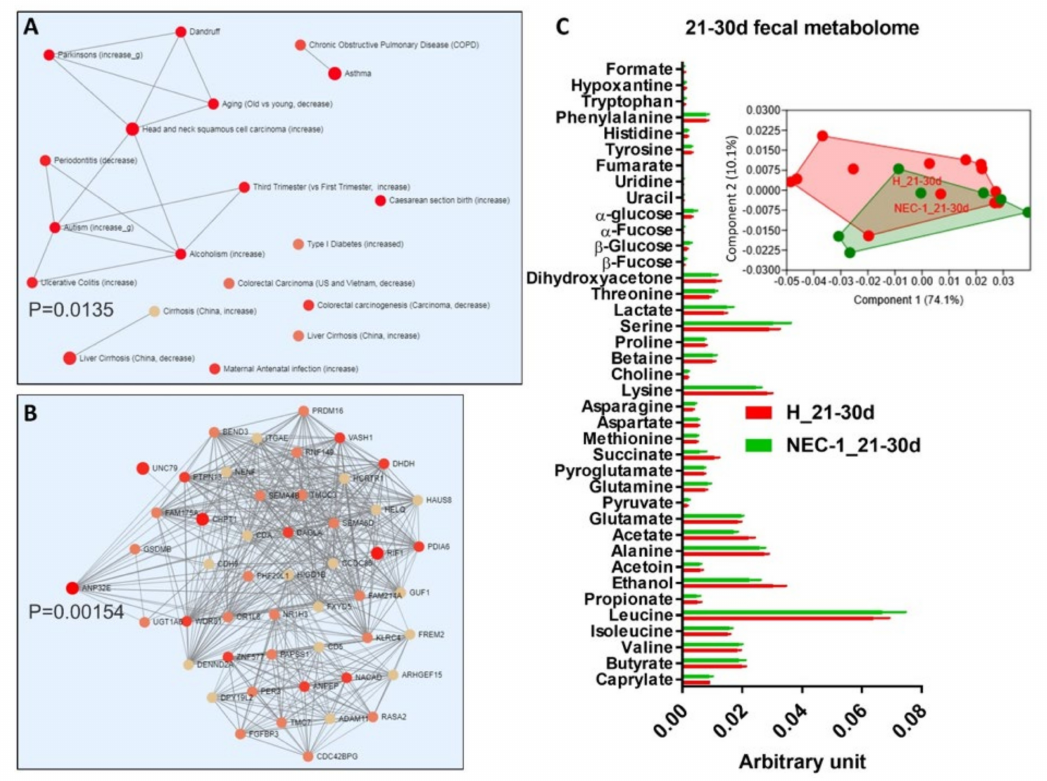
Figure 4. Diseases, host genetic variation and metabolome analysis in the third 10-days of life during NEC-1. ( A ) Diseases and ( B ) host genetic variation linked to NEC-1_21–30d associated gut microbiota; ( C ) histogram of the overall fecal metabolites and PCA, as inset. N = 13 for H and N = 7 for